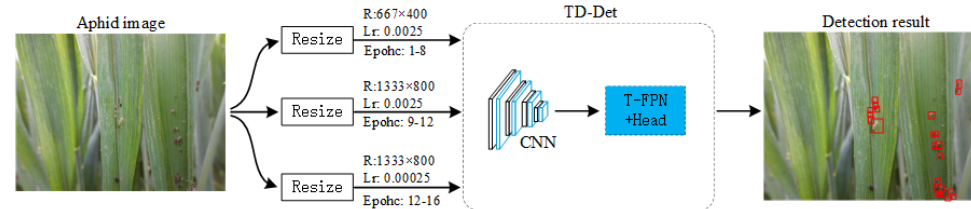
Figure 3. The architecture of the multi-resolution training method (MTM), where R is the resolution of images, Lr is the learning rate, and the red bounding boxes are detected